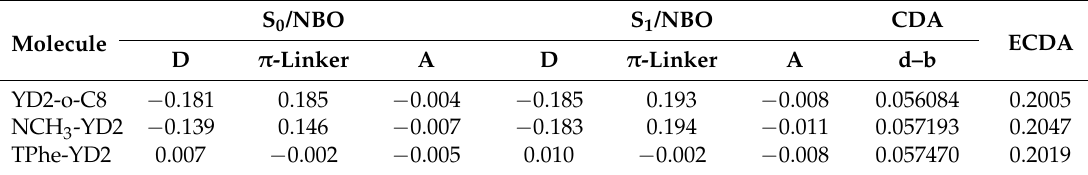
Table 2. The natural bond orbital (NBO) charge (e) of studied complexes in the ground state (S 0 ) and excited state (S 1 ) state, as well as the charge decomposition analysis (CDA) and extended charge decomposition analysis (ECDA)